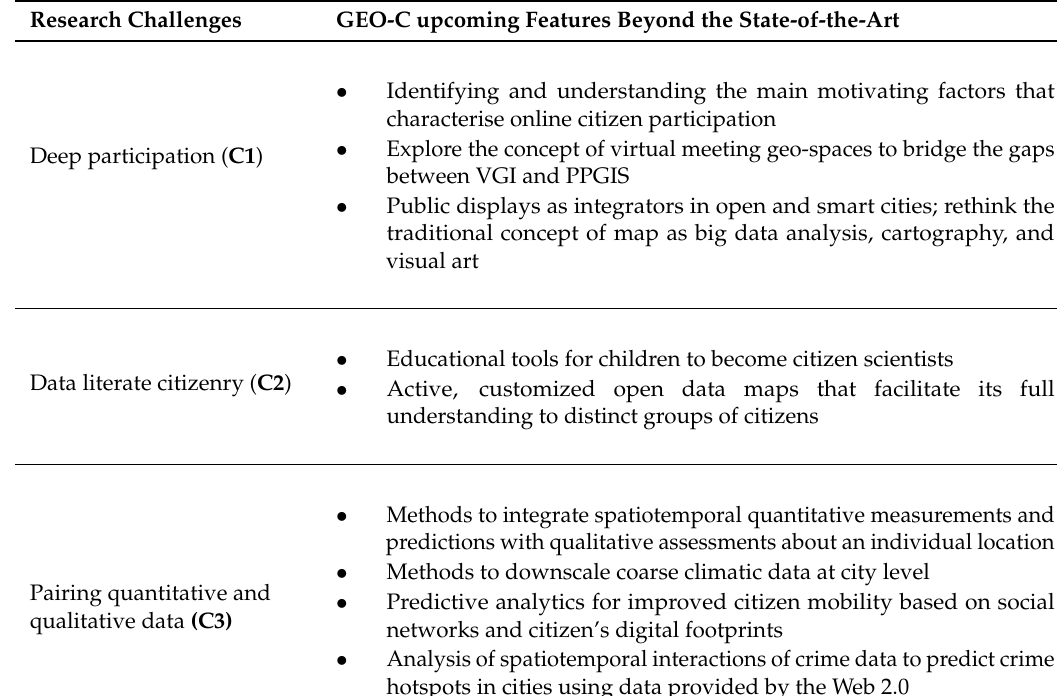
Table 4. Example research directions at the intersection between GIScience and smart